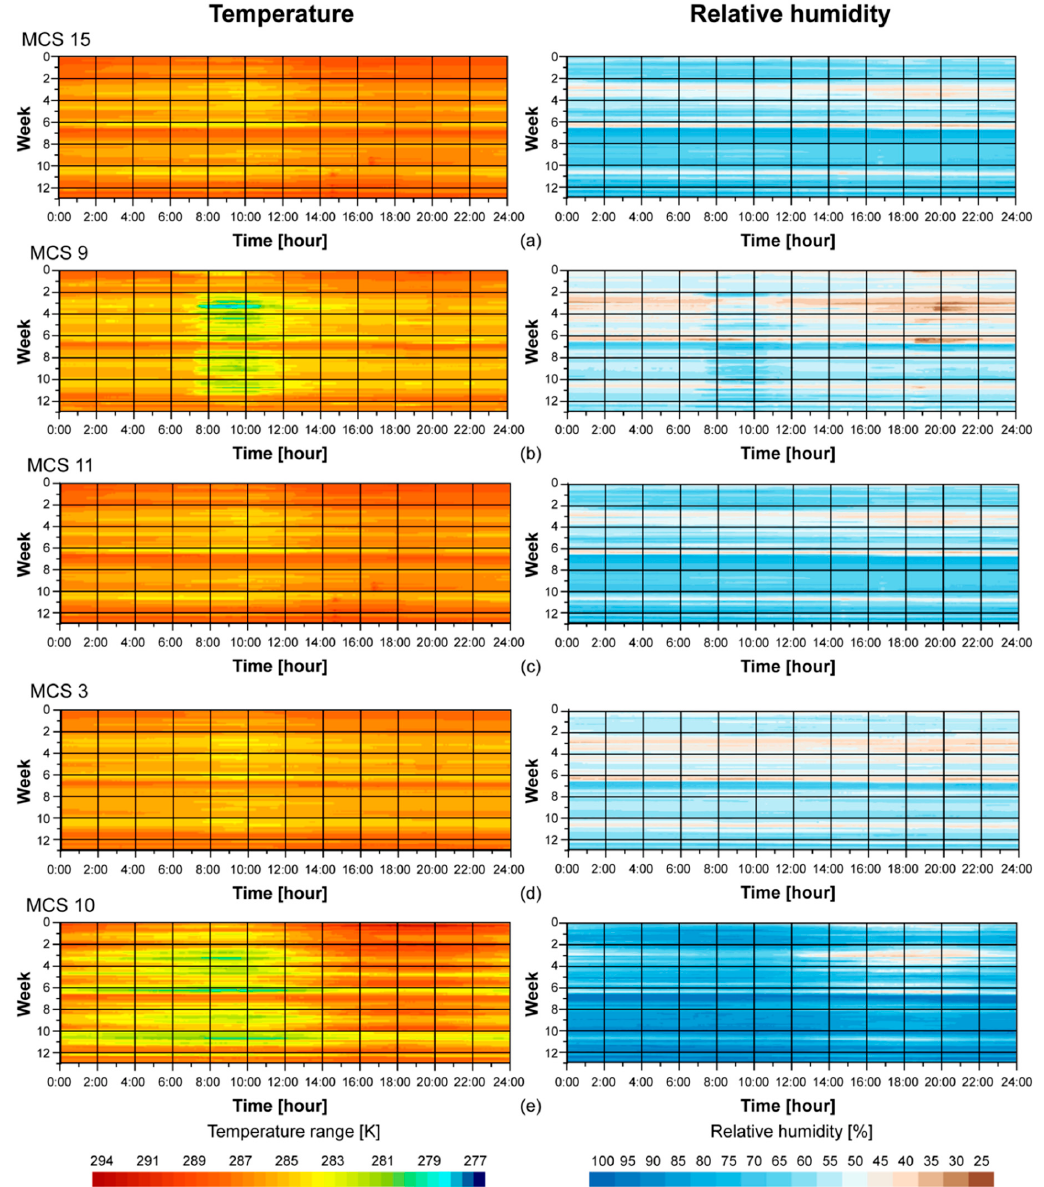
Figure 7. Time plot of RH and T every 5 min of interior MCSs: ( a ) MCS 15; ( b ) MCS 9; ( c ) MCS 11; ( d ) MCS 3 and ( e ) exterior MCS 10.